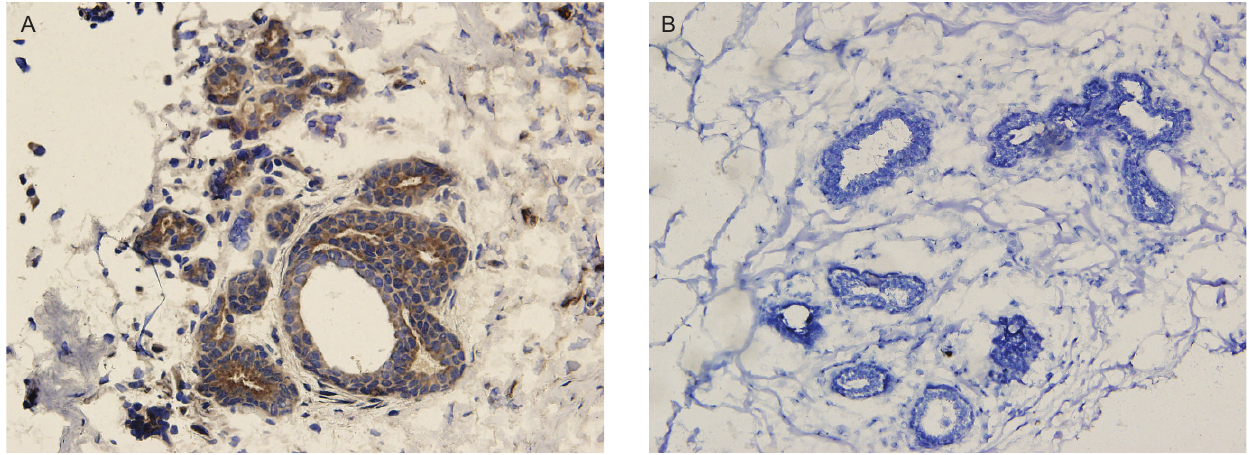
Figure 1 - The presence (a) and absence (b) of HIF-1 a expression in breast cancer cells (DAB antibody,